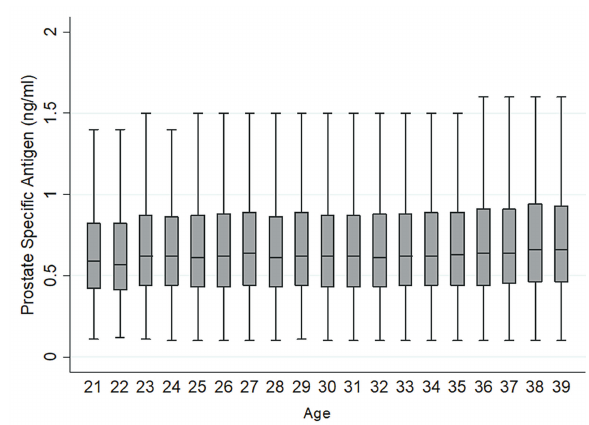
Figure 1 - Distribution of PSA values. Figure 2 - Box plot of PSA according